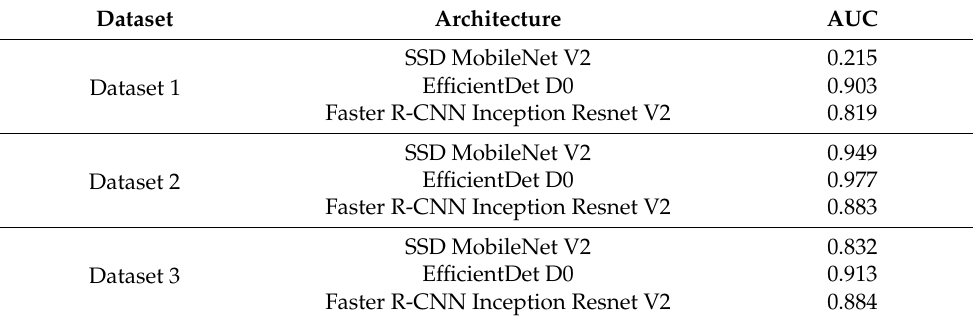
Figure 10. ROC curves of SSD MobileNet V2, EfficientDet D0, and Faster R-CNN Inception Resnet V2 from ( a ) Dataset 1, ( b ) Dataset 2 and ( c ) Dataset 3. Table 6. AUC of ROC